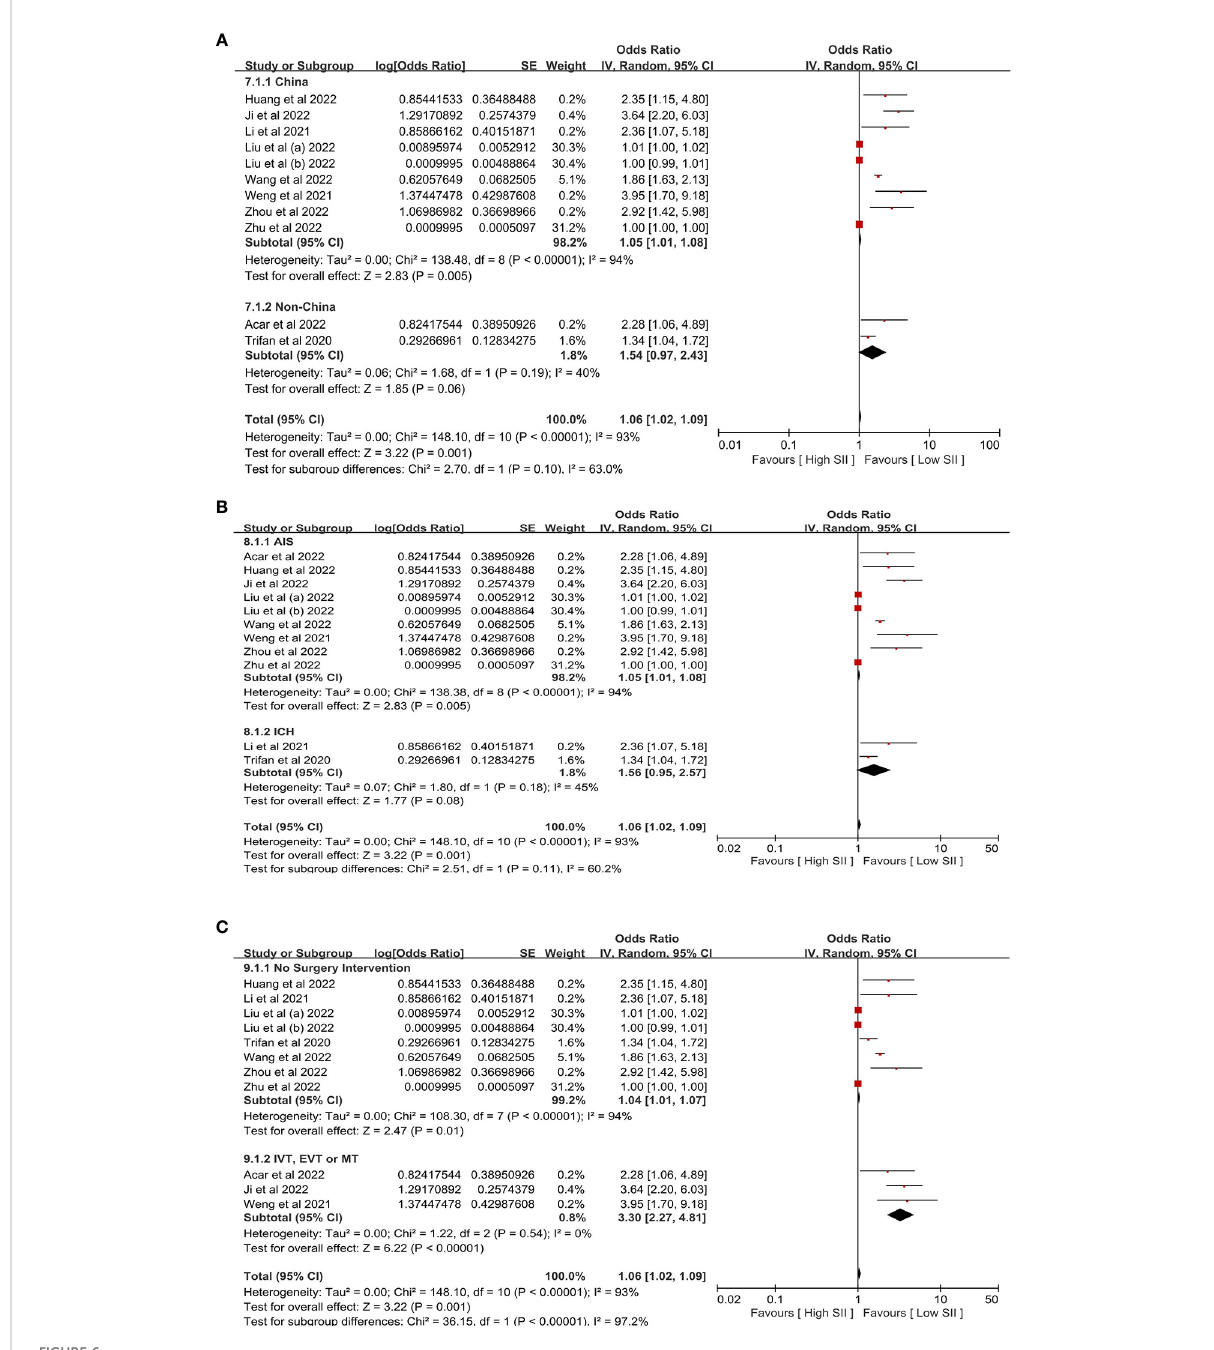
FIGURE 6 The subgroup analysis of poor outcomes is based on (A) different countries, (B) different types of stroke, and (C) surgery